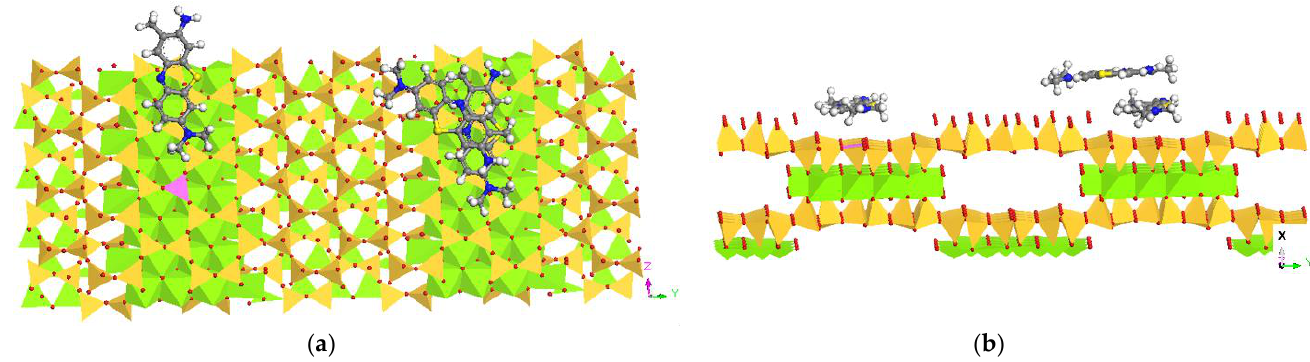
Figure 9. Molecular dynamic simulation showing the surface configuration of TB aggregates on the {100} surface ( a ) and projection along [001] ( b ) of SEP with 1 Si replaced with 1 Al in the supercell.